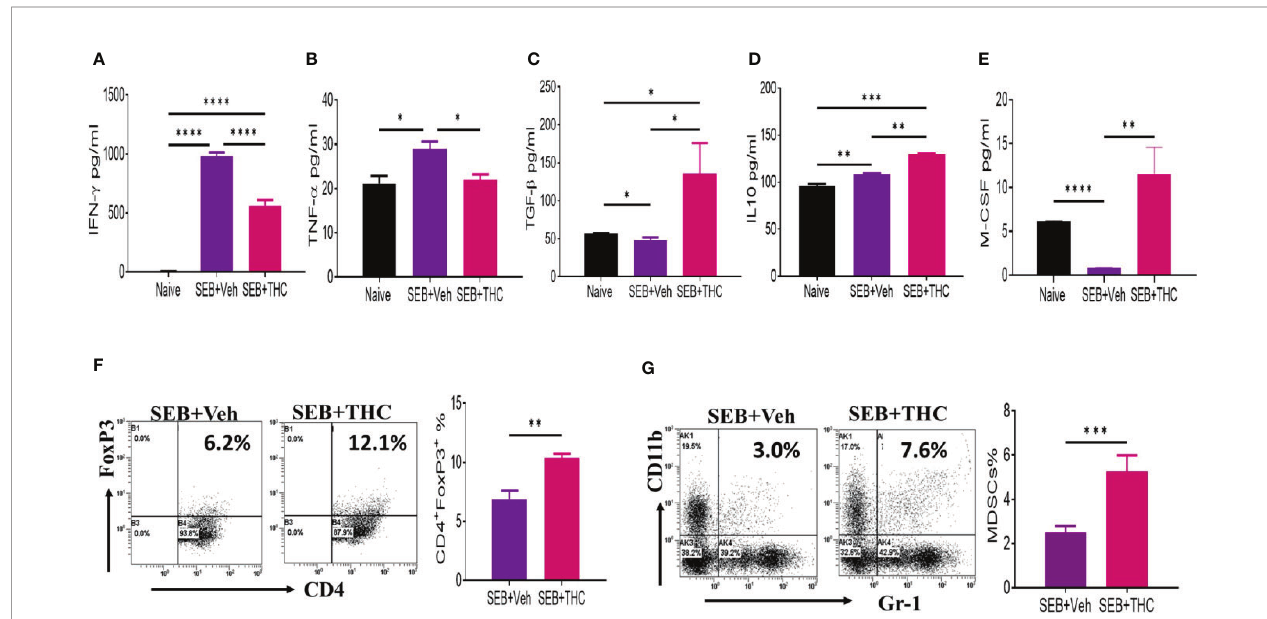
FIGURE 2 | THC suppresses in fl ammatory cytokines and induces Tregs and MDSCs. Mice were treated with SEB + Veh or SEB + THC as described in Figure 1 legend, and 72 h later the assays were performed. Panels (A – E) depict various cytokines detected in BALF using ELISA. (F) Lung MNCs stained for CD4+/FoxP3+ Tregs showing a representative experiment using fl ow cytometry. (G) Staining lung MNCs for expression of CD11b+ and Gr-1+ MDSCs, showing a representative experiment using fl ow cytometry. Vertical bars show data from groups of fi ve mice with Mean ± SEM. Data was con fi rmed in three independent experiments. Statistical signi fi cance is depicted as *p < 0.05, **p < 0.01, ***p < 0.001, ****p < 0.0001 between the